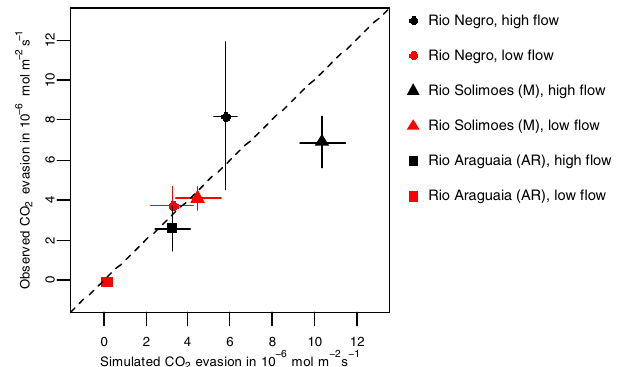
Figure 17. Observed versus simulated CO 2 evasion rates per wa- ter surface area ( R 2 = 0.64, RMSE = 1.7µmolCO 2 m − 2 s − 1 ). Ob- served data are from Rasera et al. (2013). Reported are means and standard deviation of the observed values between 2006 and 2010. Note that due to the coarse resolution of our model, only data from the largest rivers (catchment area > 100000km 2 ) are taken into ac- count. The simulated values refer to the average evasion rate during low (monthly avg. discharge < yearly avg. discharge) and high flow periods (monthly avg. discharge > yearly avg. discharge) across the whole simulation period (1980–2000). The whiskers represent the standard deviations from the inter-annual variations.